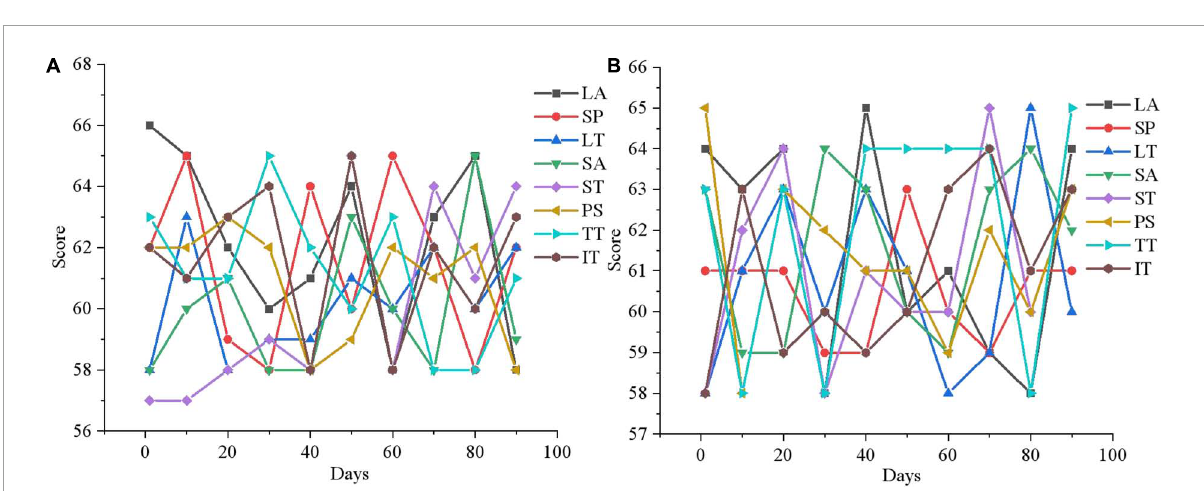
FIGURE15 Mental health evaluation results of the control group after 3 months. (A) Control group member 1; (B) control group member